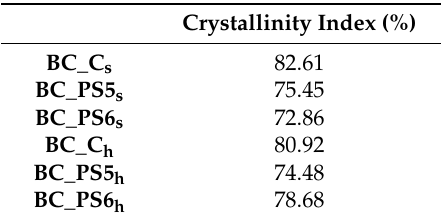
Table 1. Crystallinity index (%) of pure BC and composites made by adding [4-butyltrimethylammonium]-xylan chloride polyelectrolytes (BTMAXs) to the culture medium and to the homogenized BC.